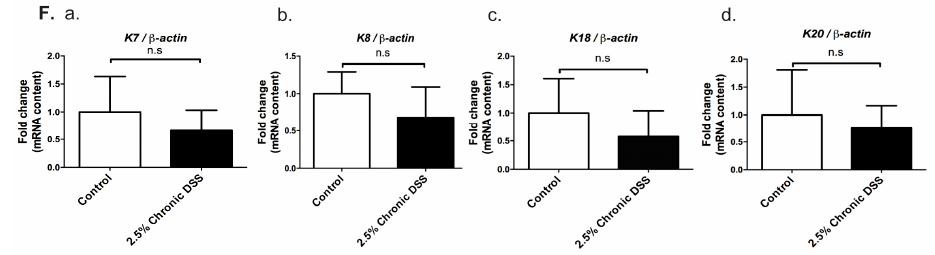
Figure 3. K7 and K20 are upregulated keratins in chronic DSS-colitis. To induce chronic colitis, mice ( n = 3 for controls, n = 3 for DSS-treated; strain FVB/n) were given two one-week cycles of 2.5% DSS with two weeks of recovery with normal drinking water after each cycle. Samples for protein, RNA and immunofluorescence analysis were collected at the end of the second recovery period (A, arrow). ( A ) The daily DAI was calculated on the basis of body weight loss, stool consistency and presence of blood in stool during the whole experimental time of 45 days to follow colitis progression during DSS-treatment and the 2-week recovery periods. ( B , C ) A significant upregulation of K7 and K20 protein levels (as quantified in Figure 1) was seen after chronic DSS-treatment. *** p < 0.001. ( D ) Immunofluorescence staining shows that K7 (panels a, c in red) was expressed all over the crypt and also in the top-most crypt cells after chronic DSS-treatment (panel c) compared to controls (panel a). K20 (panels b, d in red) showed a broader crypt-distribution in response to chronic DSS (panel d) compared to controls (panel b). L = lumen, scale bar = 50 μ m. Nuclei (DNA) are shown in blue. ( E ) Crypt length and K20-positive crypt areas (white bars) compared to K20 negative crypt areas (black bars) were quantified in controls and after chronic DSS-treatment. ( F a–d) Gene transcription analysis from samples collected on day 45 as indicated in ( A )) showed no significant changes in the gene transcription of K7, K8, K18 and K19. n.s = not significant. Numerical data are shown as average ± SD. Statistical significance for Western blot and mRNA data was determined by t-test.